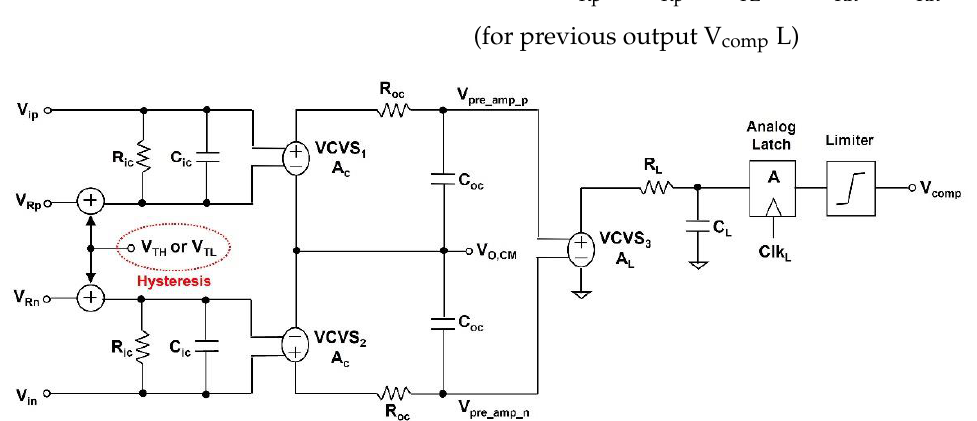
Figure 5. Comparator macro model.